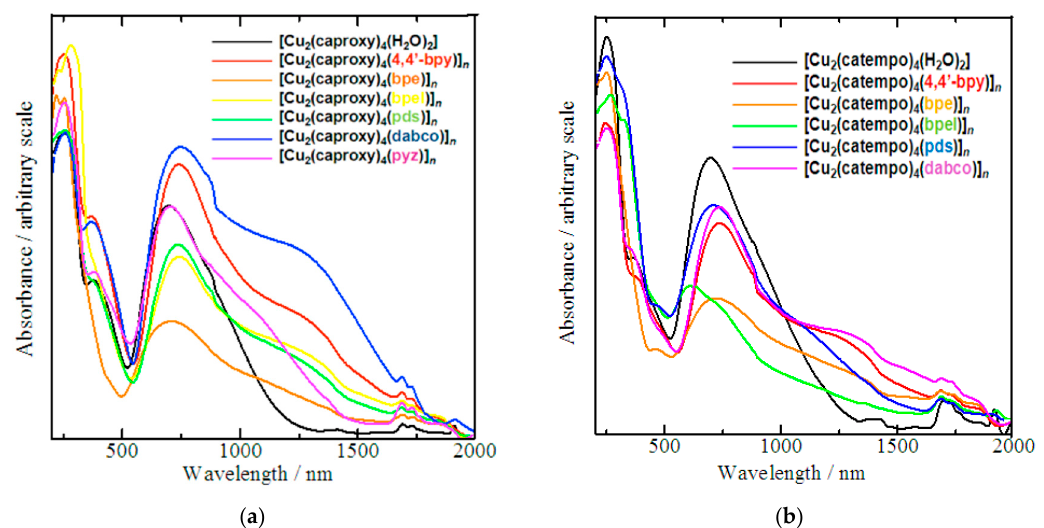
Figure 4. Diffused reflectance spectra of chain compounds ( a ) [Cu 2 (caproxy) 4 (L)] n and ( b ) [Cu 2 (catempo) 4 (L)] n .